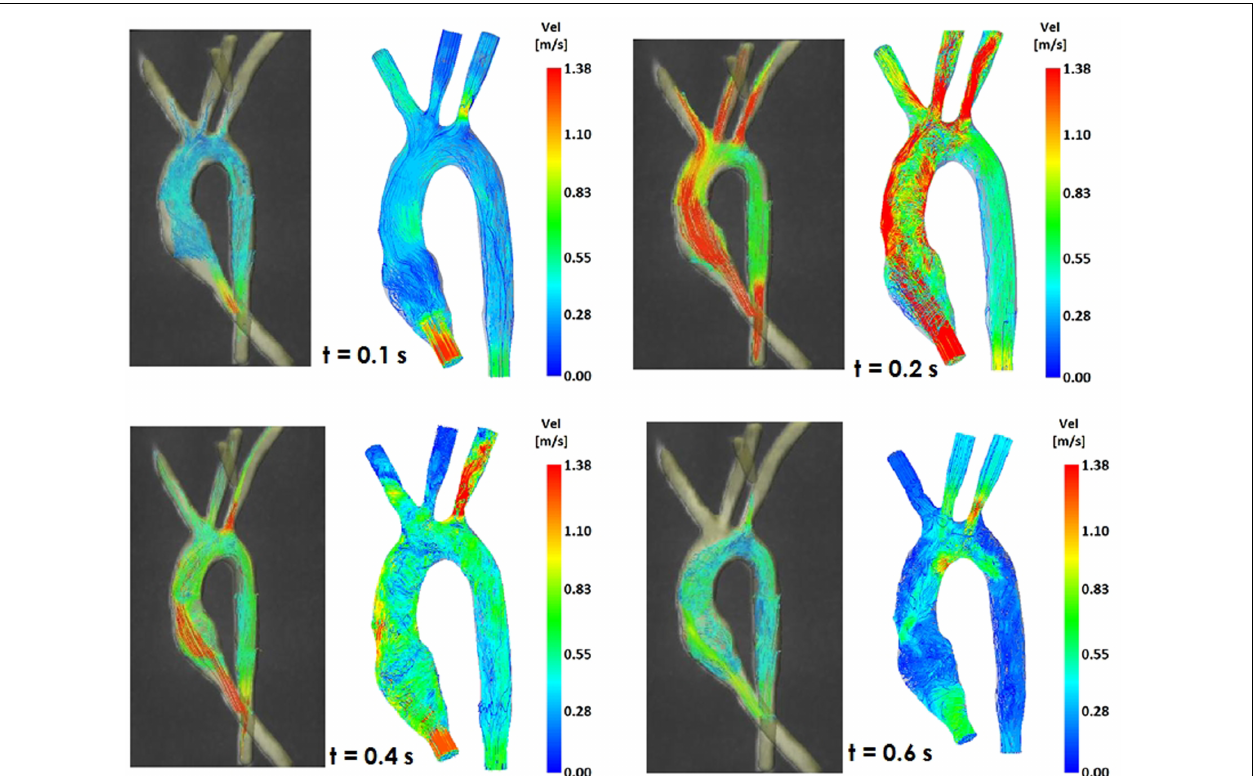
FIGURE 5 | Comparison of flow streamlines in the control 3D model, 4D CMR data ( left ) and CFD results ( right ), at four different time points in the cardiac cycle .